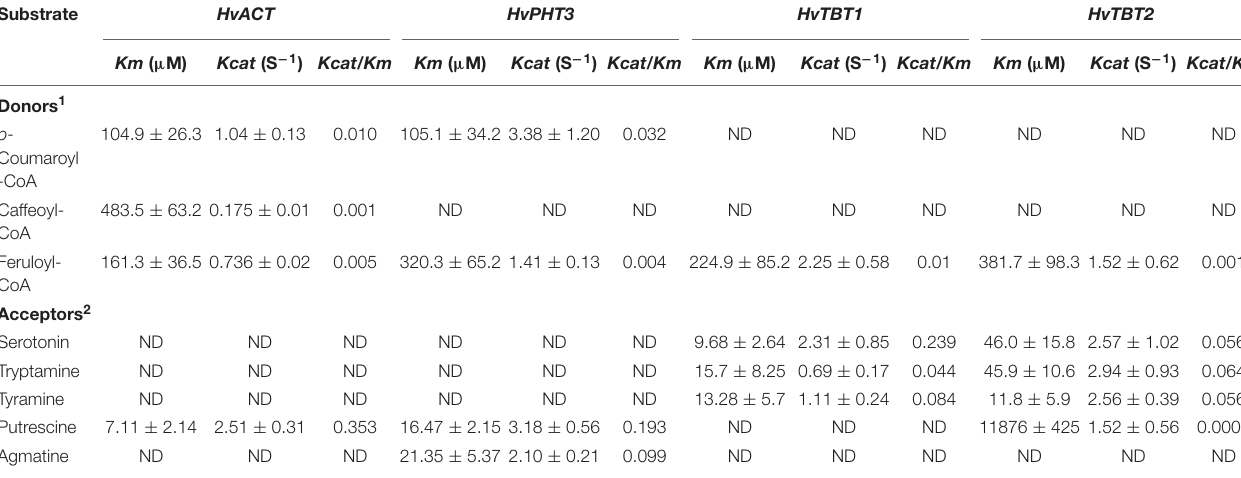
TABLE 1 | Kinetic parameters of HvACT , HvPHT3 , HvTBT1 and HvTBT . Substrate